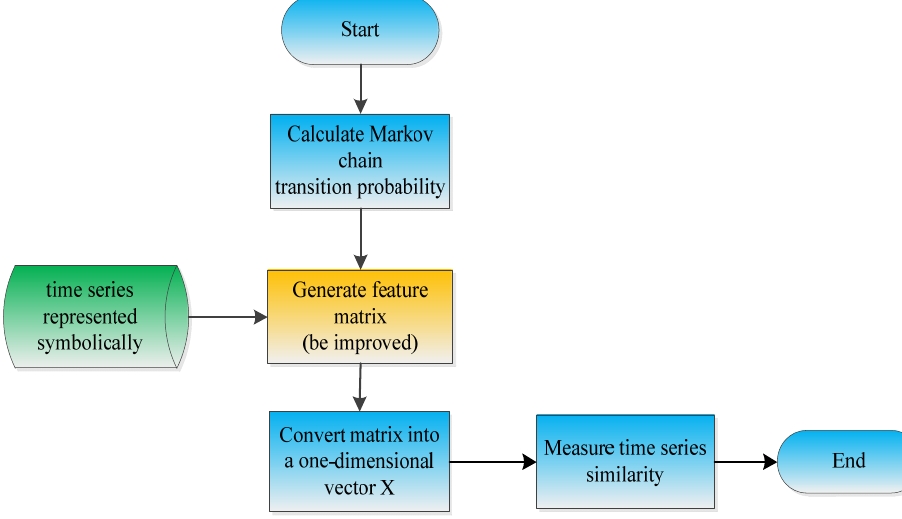
Figure 2. The flow of time series similarity measurement method is based on Markov chain. Each symbolized time series S = { s 1 , s 2 , . . . , s n } satisfies Markov property, that